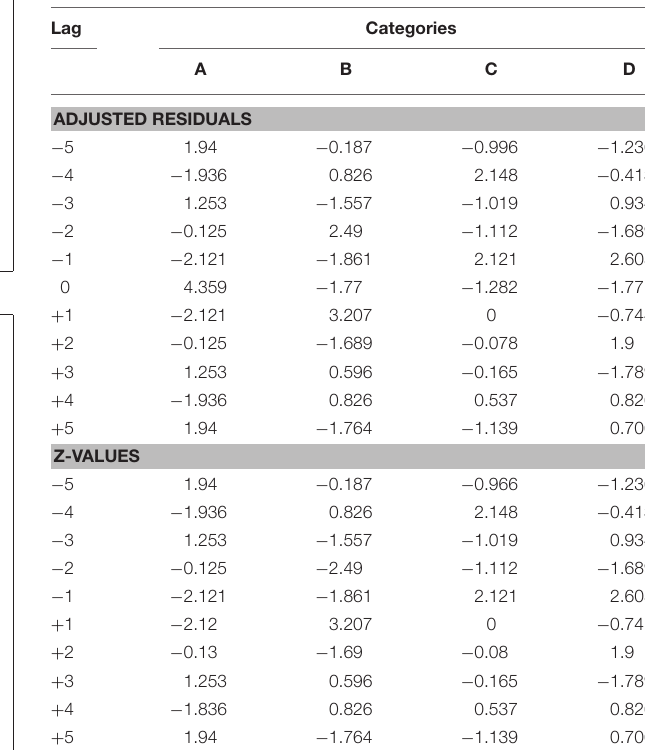
TABLE 7 | Adjusted residuals and corresponding Z -values from the polar coordinate analysis with A as the focal behavior or category and B, C, and D as the conditional behaviors.